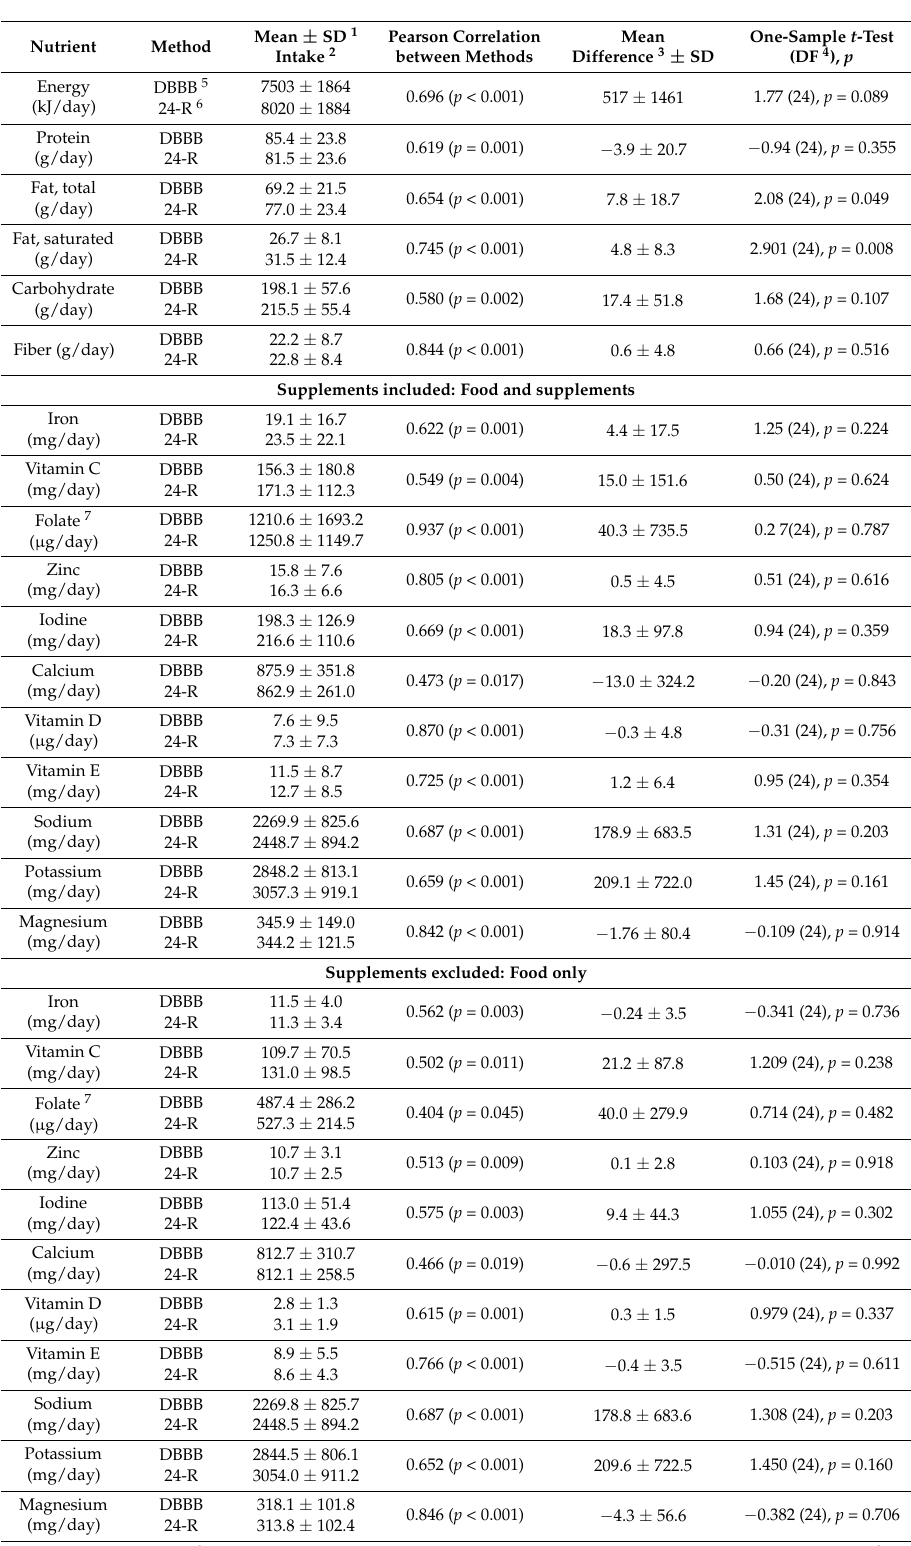
Table 2. Comparison of energy and nutrient intake between the DietBytes image-based dietary records and 24-h food recall methods ( n =